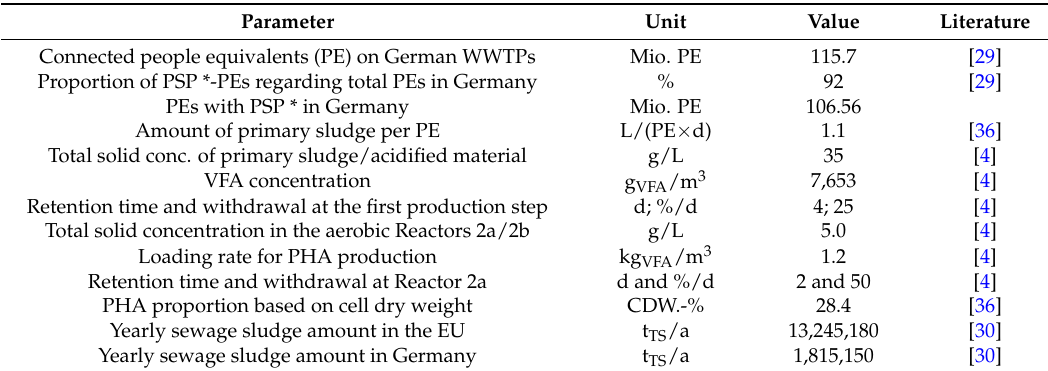
Table 1. Input data used during the potential